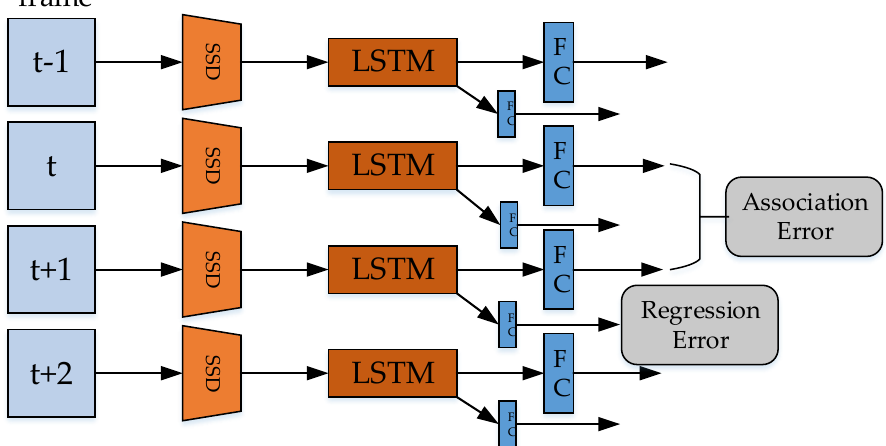
Figure 13. The architecture of Association LSTM. SSD is a one-stage detector, which is described before. FC is the fully connected layers. Association Error generates the object classification, Regression Error generates the object localization.